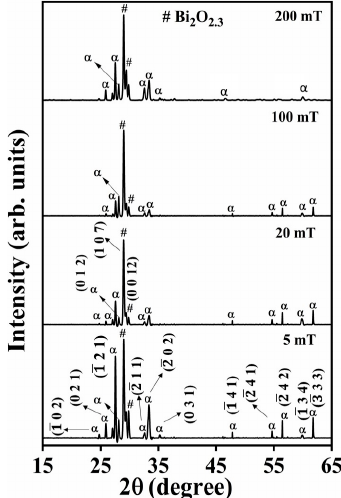
Figure 2. XRD patterns of Bi 2 O 3 :Ho 3+ thin films deposited at the different oxygen partial pressures with constant substrate temperature at 400 °C.